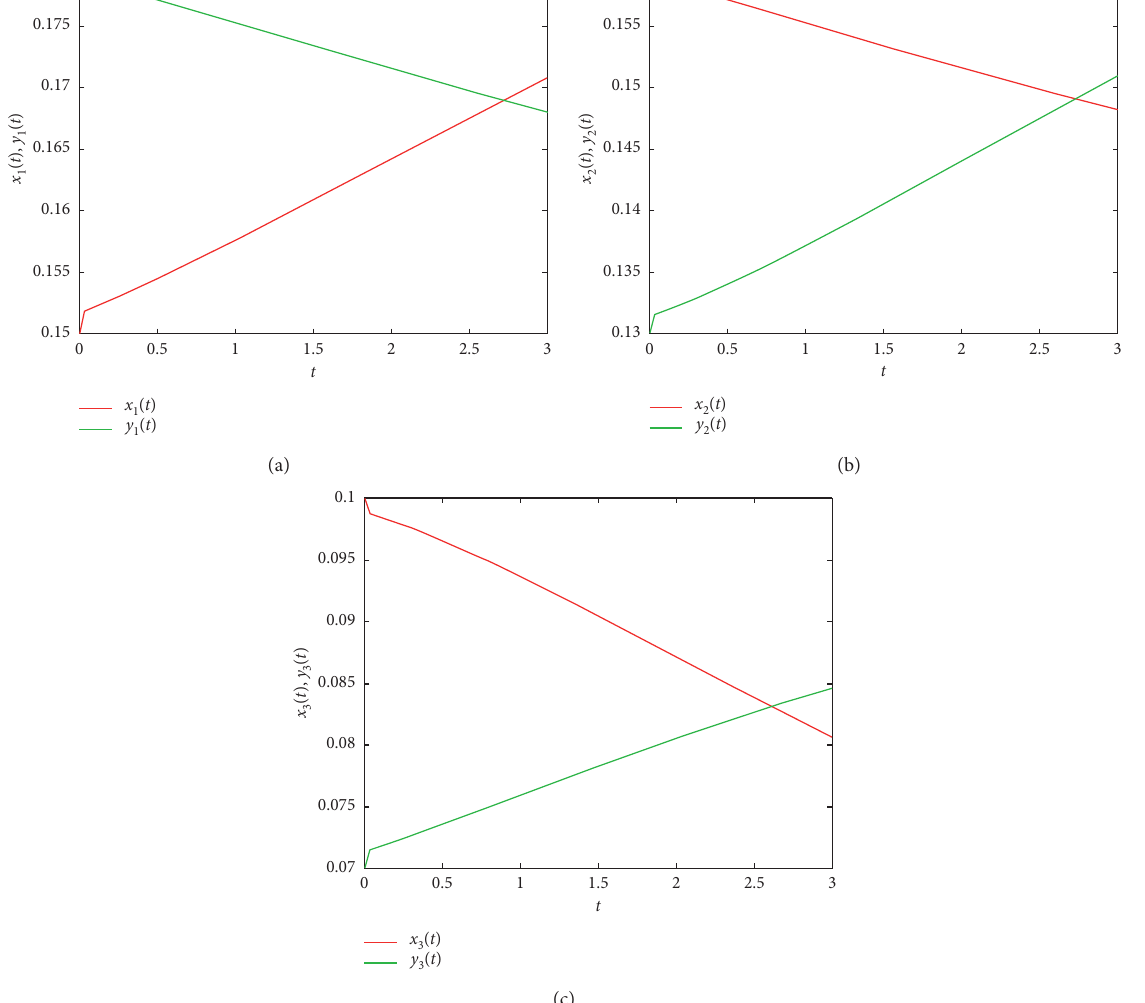
Figure 3: The time response for x ( t ) and y ( t )